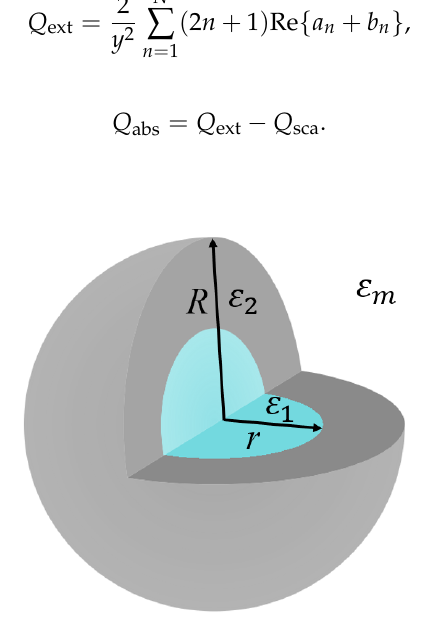
Figure 1. A schematic of the core@shell particles with outer radius R considered in this work. The sphere has an inner core radius r with permittivity ε 1 . It is coated with a homogeneous layer of uniform thickness R − r and permittivity ε 2 . The permittivity of the medium is ε m